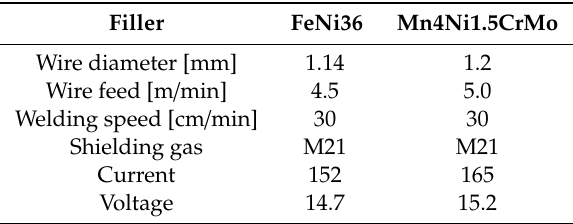
Table 1. Welding parameters for preferred direction specimens.